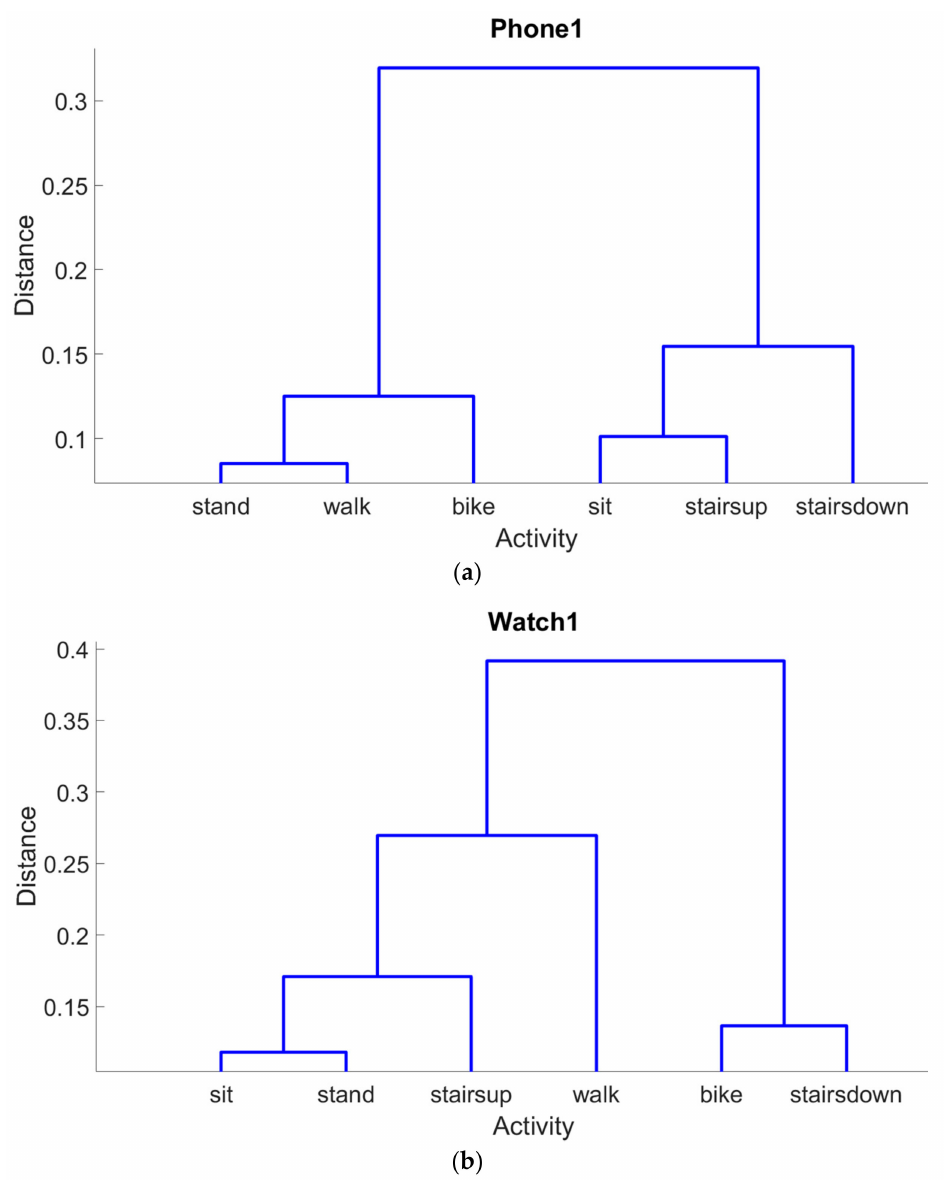
Figure 8. HCA Clustering visualizations of ( a ) Phone1 and ( b ) Watch1